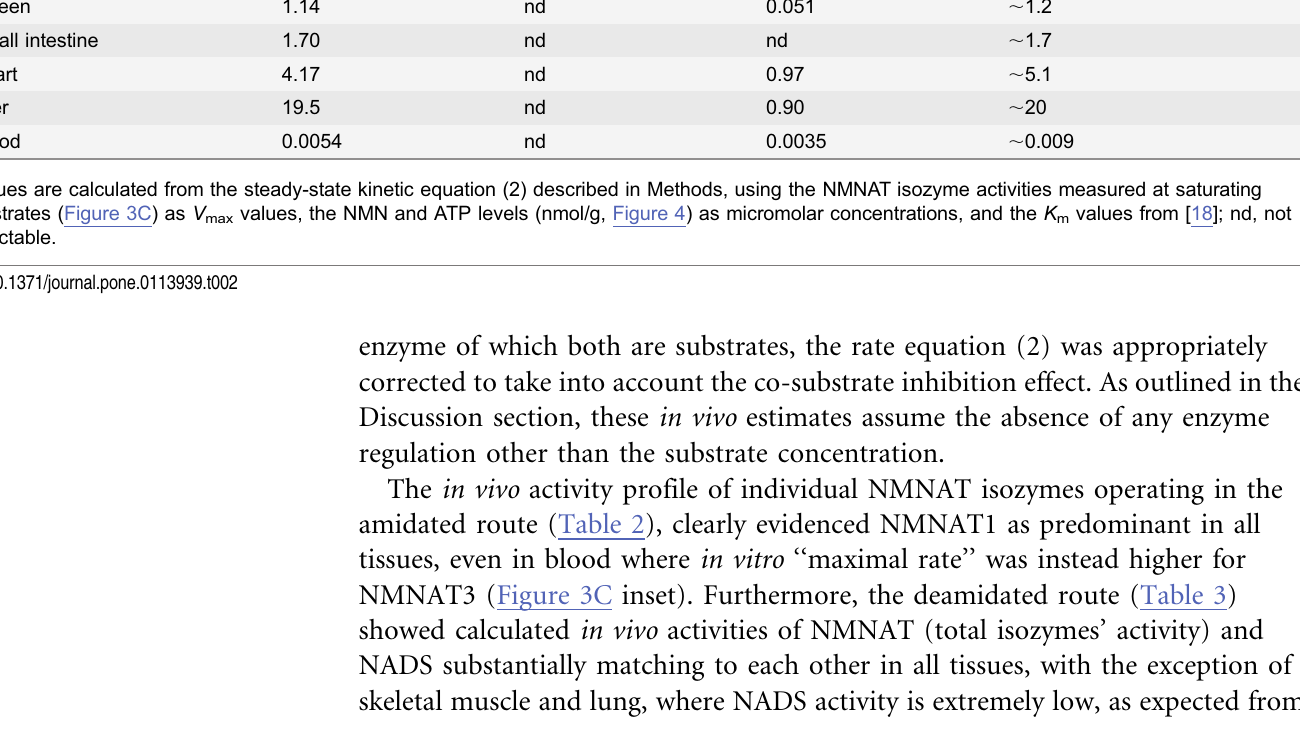
Table 3. Deamidated route: estimates of NMNAT and NADS physiological activities.